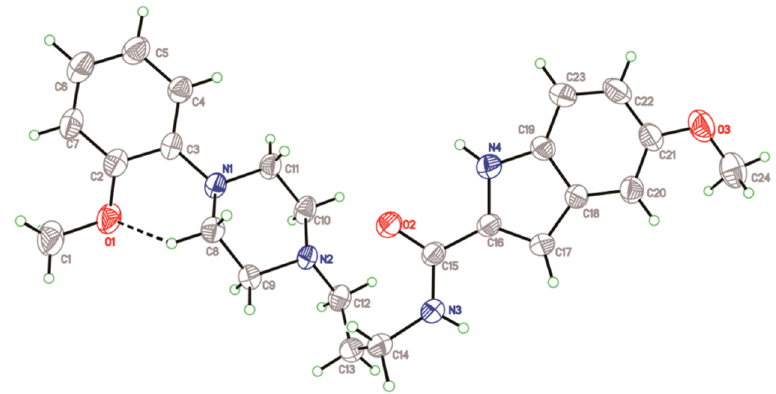
Figure 4. Crystallographic structure of compound 2 . Displacement ellipsoids are drawn at the 30%